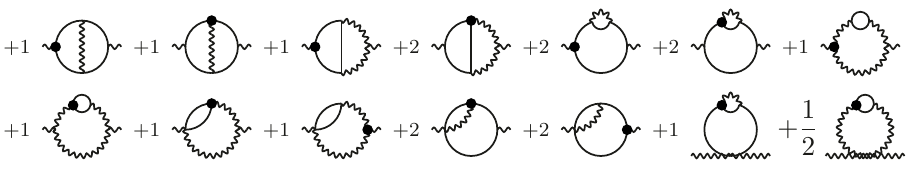
Figure 3 . 2-loop contributions to the 2-point function, originating from 2-point Chapman vertices, denoted by filled blobs. Adjoint scalars are denoted by solid lines. Graphs involving closed massless loops, which do not contribute to the matching, have been omitted.